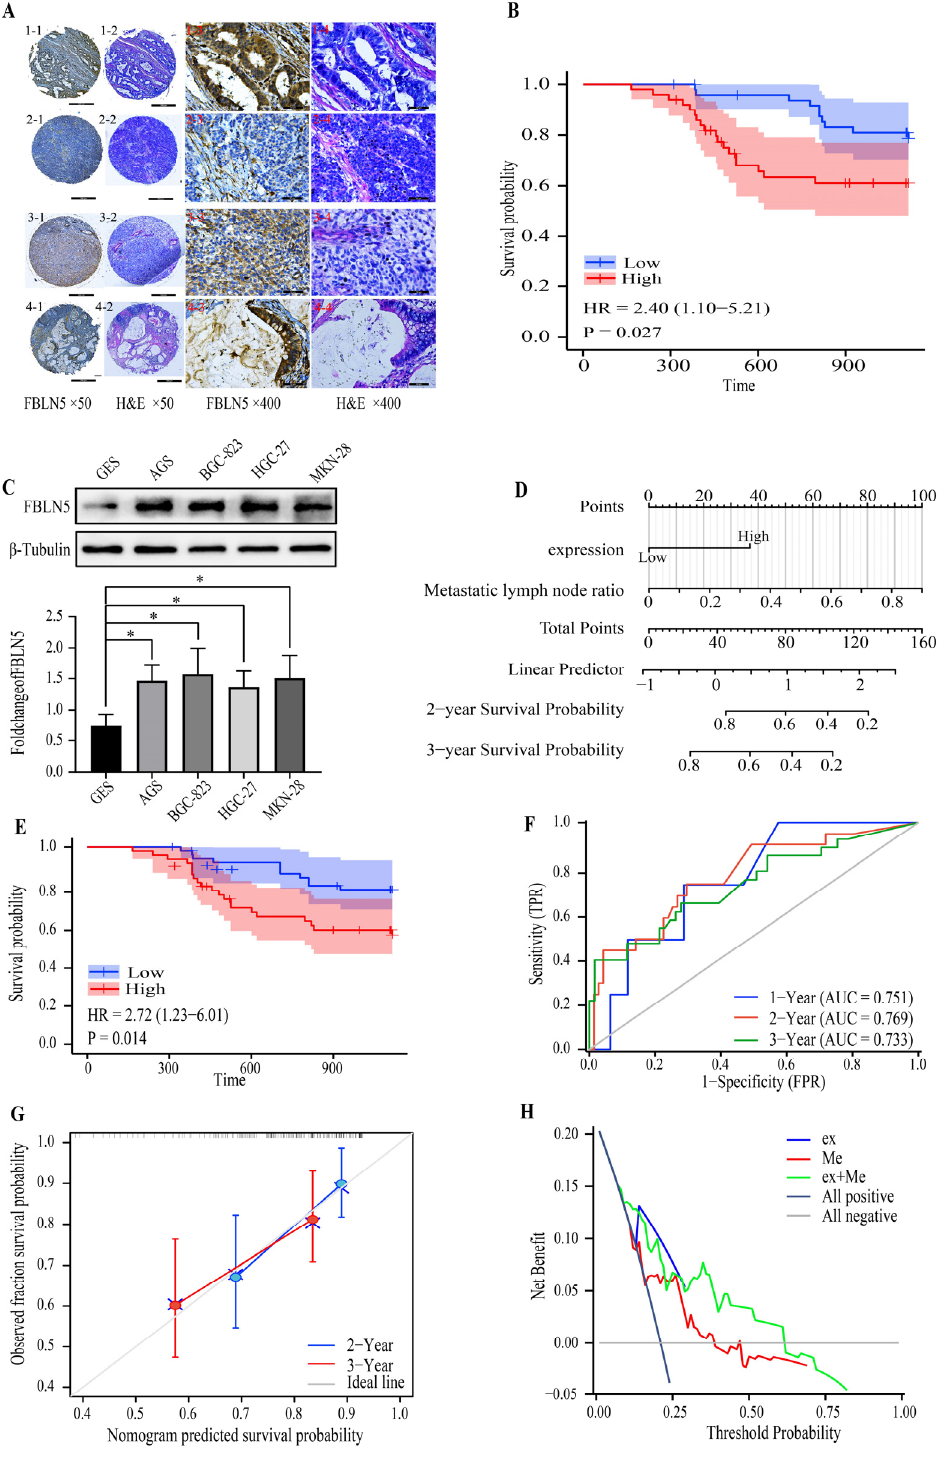
Figure 6. FBLN5 expression levels and prognostic model establishment. ( A ) FBLN5 immunohisto- chemistry and H&E staining of GC TMA, ×50 and ×400 total magnification. ( A1 ) Well-differentiated adenocarcinoma. High expression of FBLN5 in the cytoplasm of cancer cells and tumor interstitial fiber cells. ( A2 ) Poorly differentiated adenocarcinoma. FBLN5 is expressed at low levels in the